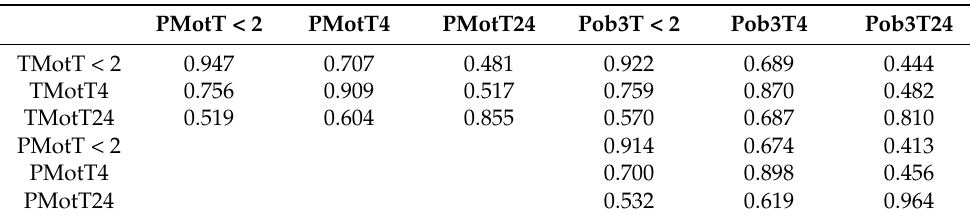
Table 1. Pearson coefficients ( r ) for correlations between total and progressive motility and sp3 in bull semen, determined with CASA after three durations of storage in the presence of three semen extenders at two holding